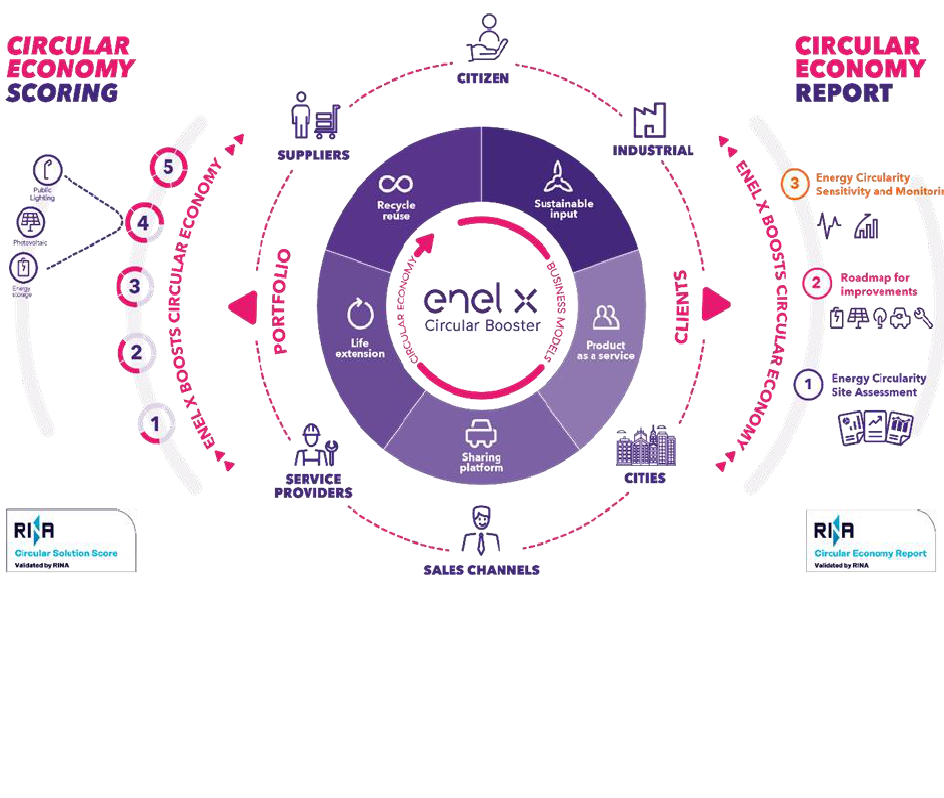
Figure 4: Circular Economy Boosting